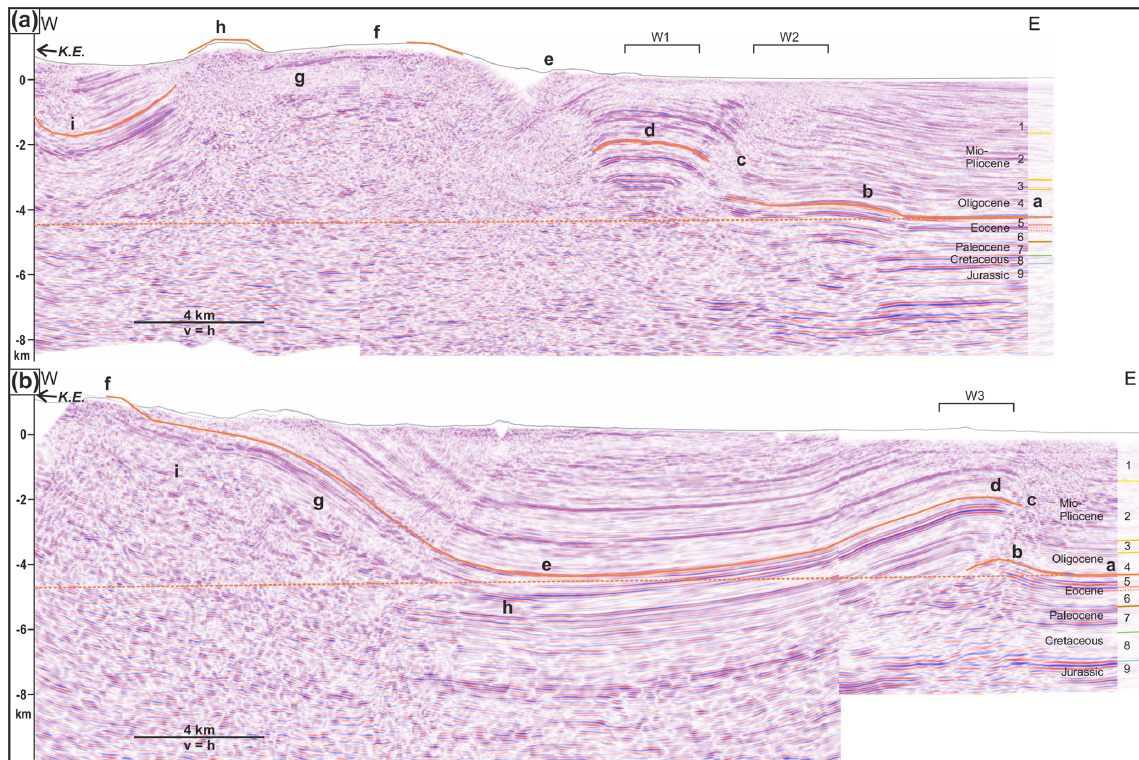
Figure 9. Two W–E-oriented pre-stack depth-migrated seismic sections. Orange interpretations indicate the clearly constrained top of the Kirthar Formation from seismic, well and outcrop data. The stippled orange line is the anticipated pre-contractional regional elevation of the Kirthar Formation. K.E.: Kirthar Escarpment. A high-resolution image without interpretation is available as a Supplement figure. The final interpreted seismic lines are part of Figs. 12a and 13a; (a) seismic section composed from two overlapping 2-D seismic lines in the northern sector (exact position not shown for confidentiality reasons). W1: well control within 4km (to Jurassic level). W2: well control within 5km (to Paleogene level). Labels a–i are used to indicated features discussed in the text. Numbered horizons in the east refer to horizons as in Fig. 4; (b) section composed from 2-D and 3-D seismic data. W3: well control within 1km (to Upper Cretaceous level). Labels a–i are used to indicated features discussed in the text. Numbered horizons in the east refer to horizons as in Fig.